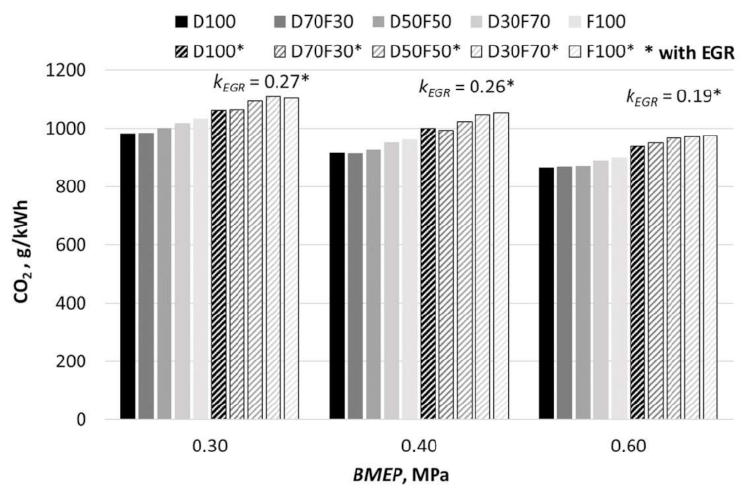
Figure 13. Dependence of CO 2 emissions on fuel composition and engine